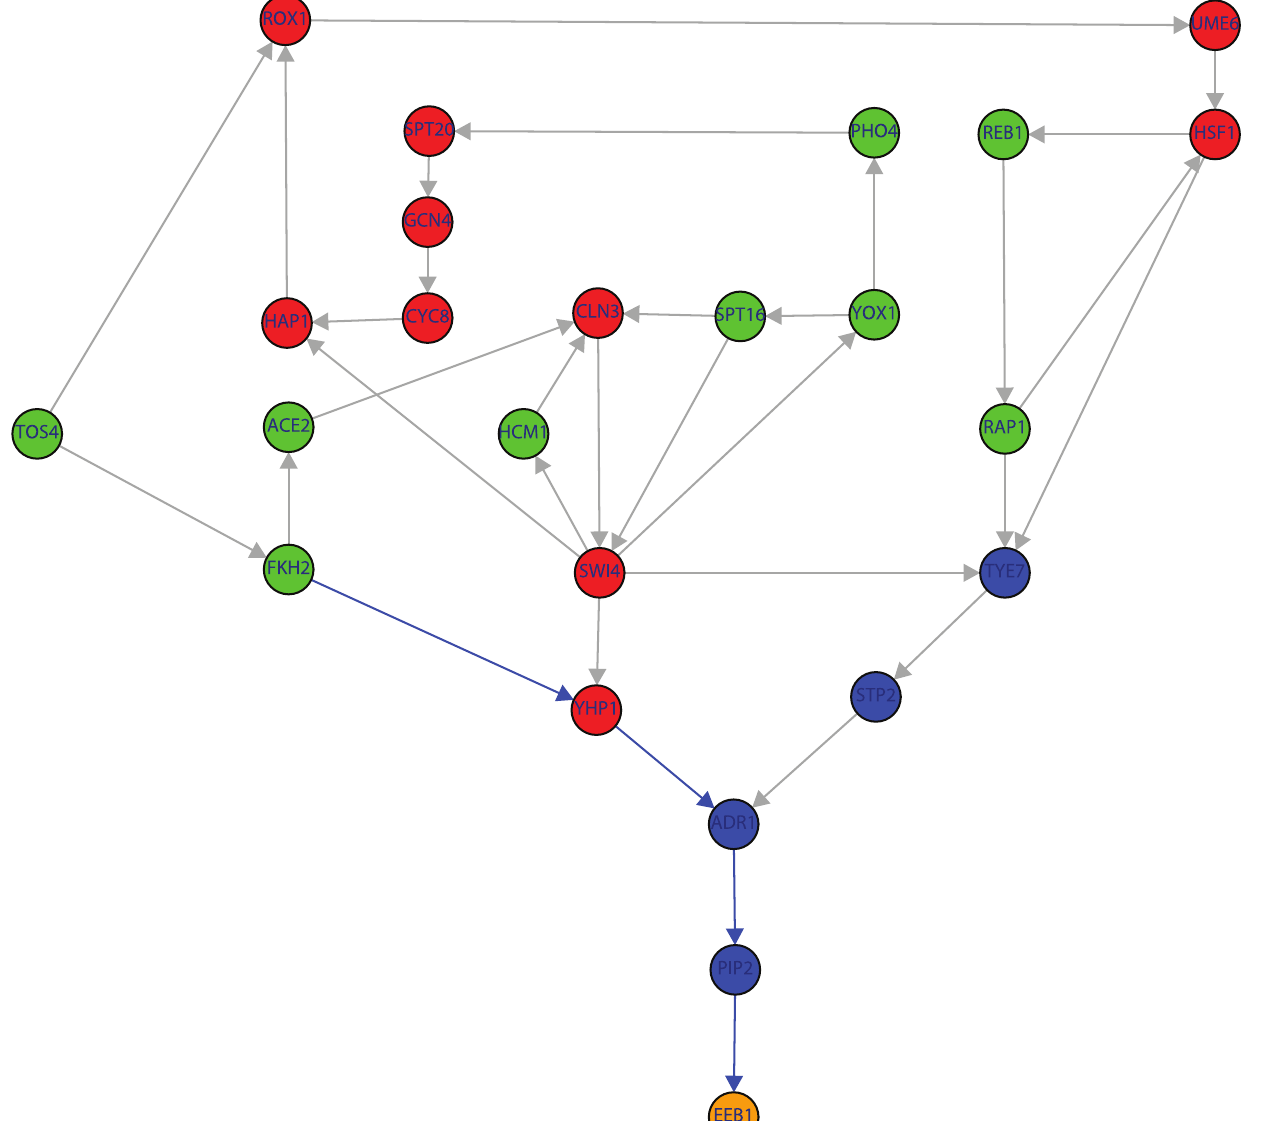
Figure 6. Subnetwork of the TRN of yeast containing 24 genes. Color code of the nodes is as in Fig. 1. The shown subnetwork complements the results in table 1 by providing detailed information about the genes involved in the shortest paths. Blue edges indicate the shortest path connecting FKH2 R YHP1 R ADR1 R PIP2 R EEB1.